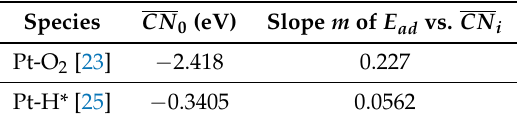
Table 4. Linear fit of E ad for